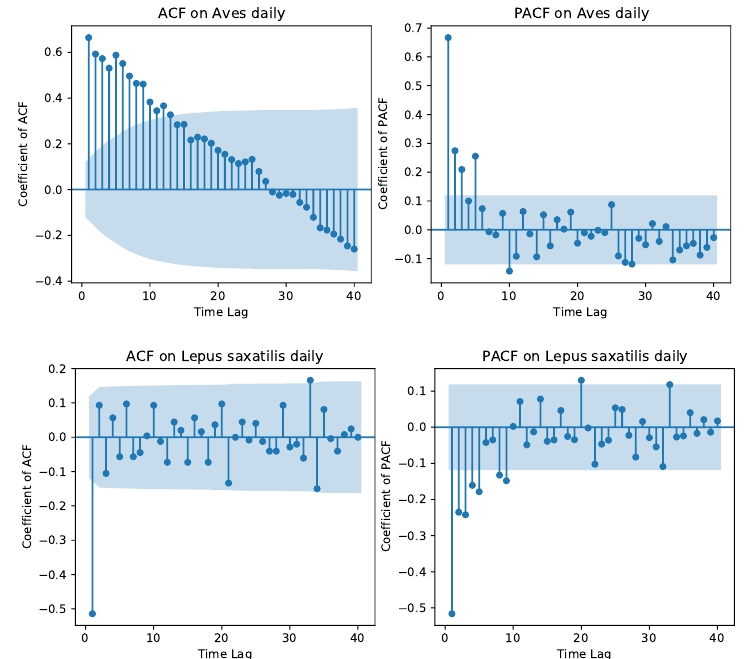
Figure 3. ACF (top-left panel) and PACF (top-right panel) on the Aves data showing stationarity. ACF (bottom-left panel) and PACF (bottom-right panel) on the Lepus saxatilis data showing non-stationarity on endogenous variables and over differenced Lepus saxatilis series with a lot of negative values.